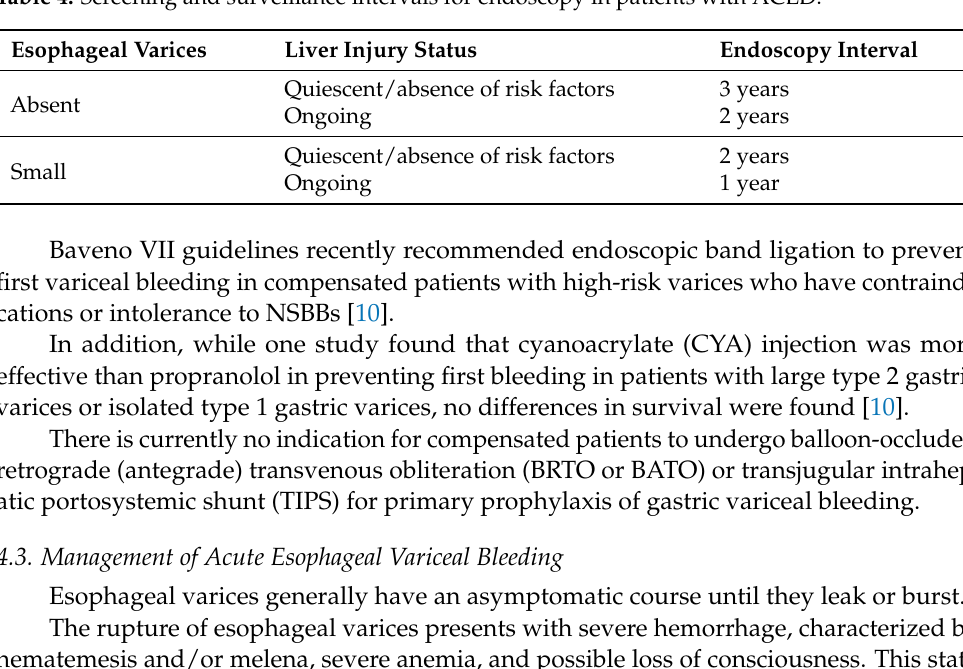
Table 4. Screening and surveillance intervals for endoscopy in patients with